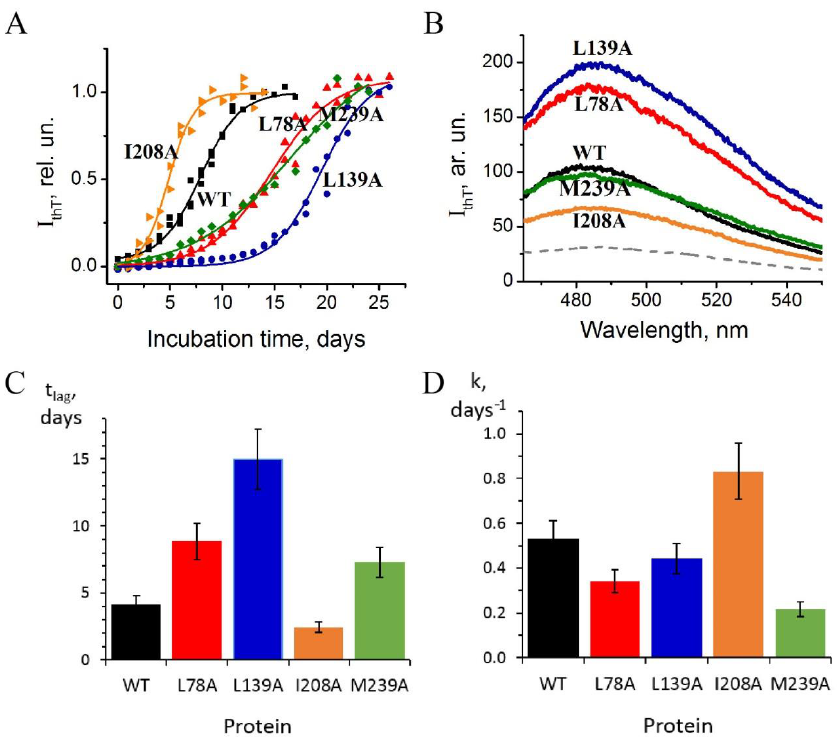
Figure 5. ( A ) Dependence of intensity of thioflavin T fluorescence at 480 nm on time of incubation at pH 2.7, 57 °C, in the samples of carbonic anhydrase: wild-type (black), L78A (red), L139A (blue), I208A (orange), M239A (green). The signal is normalized to the plateau value. Solid lines are the approximations with the Boltzmann function. ( B ) Fluorescence spectra of thioflavin T in the samples of carbonic anhydrase solutions after reaching the plateau of kinetic curves shown in A; gray dashed line indicates the spectrum of thioflavin T in the wild-type carbonic anhydrase before protein incubation. ( C ) Lag times, t lag , and ( D ) growth rate constants, k, for the kinetic traces shown in ( A ) for the calculation, the method published in [24].